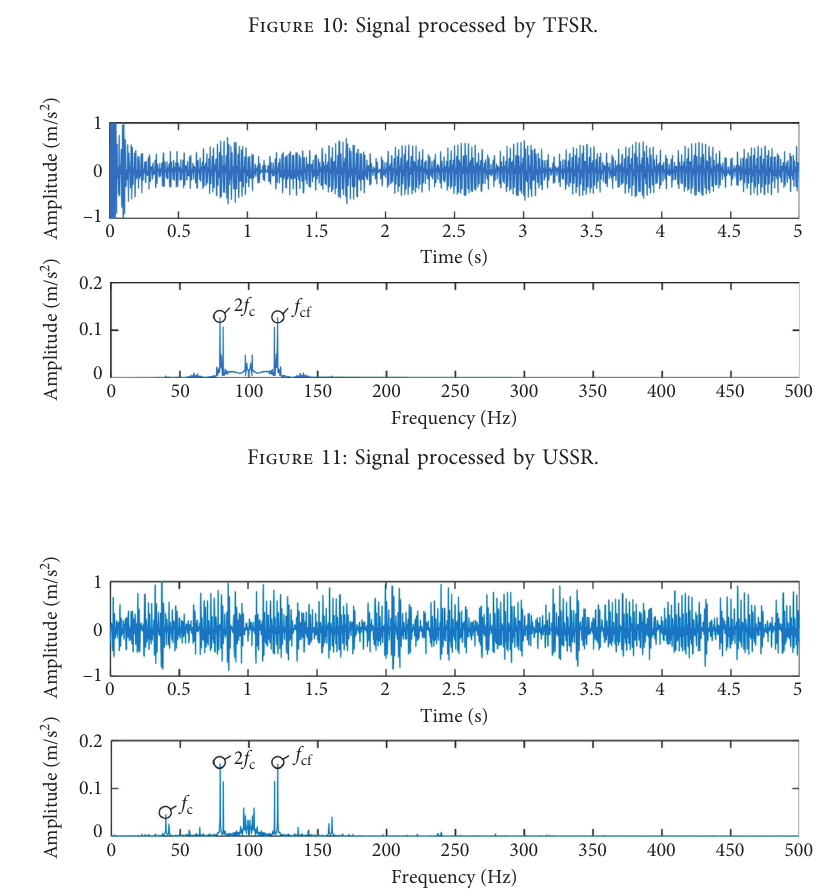
Figure 12: Signals processed by USAGVSR.